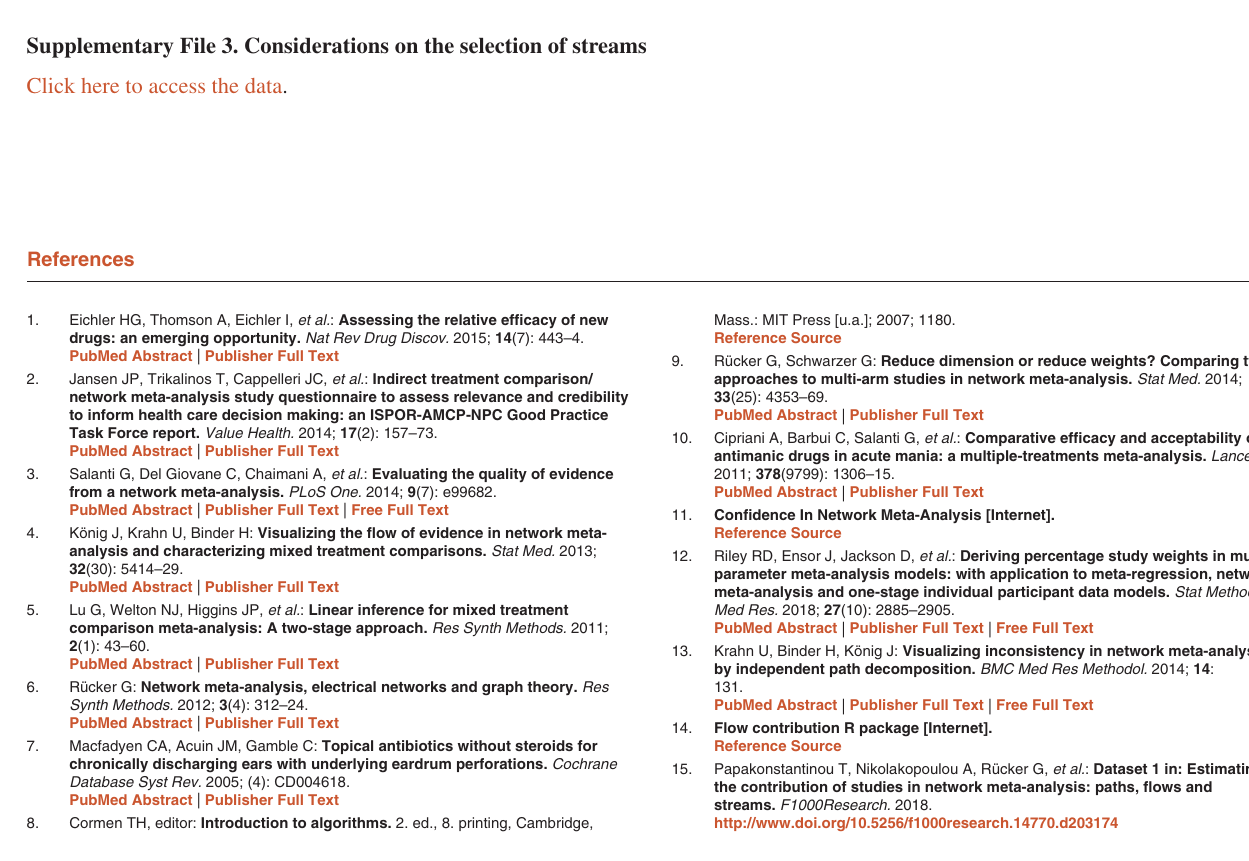
Supplementary File 2. Proportion contribution matrix P for the network of antimanic drugs. Cells show the proportion contri- bution of direct comparisons indicated in the column to the network meta-analysis treatment effects indicated in the rows. ASE, asenapine; ARI, aripiprazole; PLA, placebo; HAL, haloperidol; QUE, quetiapine; LITH, lithium; ZIP, ziprasidone; OLA, olanzapine; DIV, divalproex; RIS, risperidone; CARB, carbamazepine; LAM, lamotrigine; PAL, paliperidone; TOP, topiramate; ASE, asenapine. Click here to access the data. Supplementary File 3. Considerations on the selection of streams Click here to access the